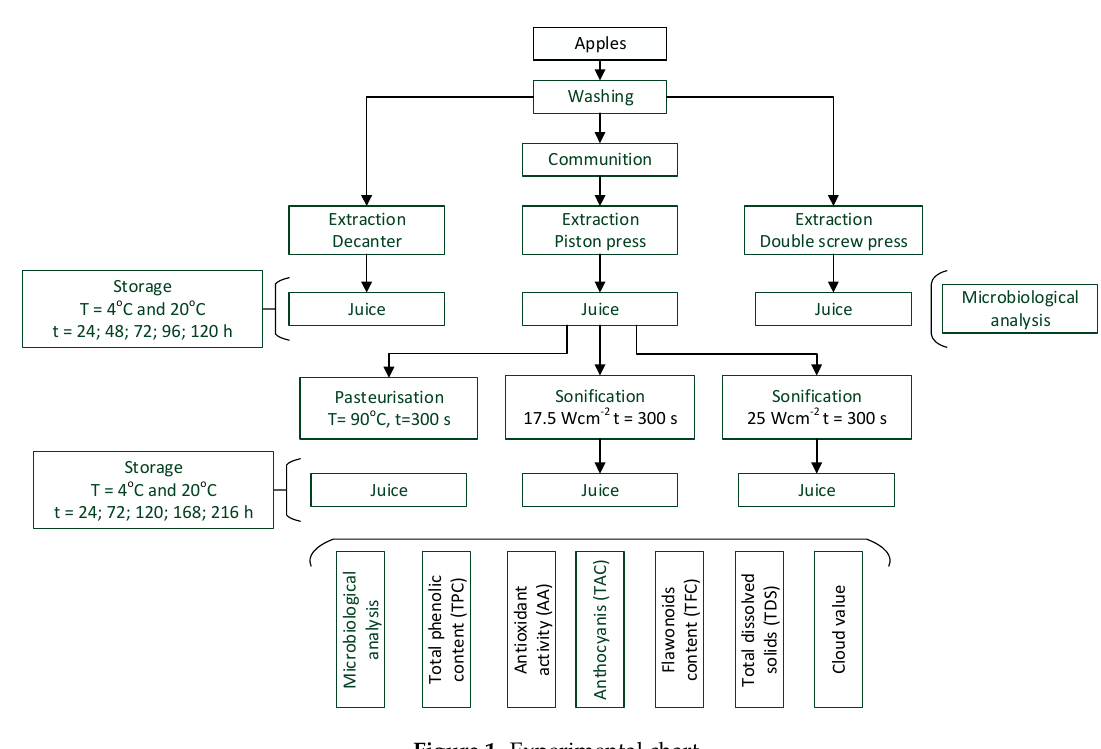
Figure 1. Experimental chart.